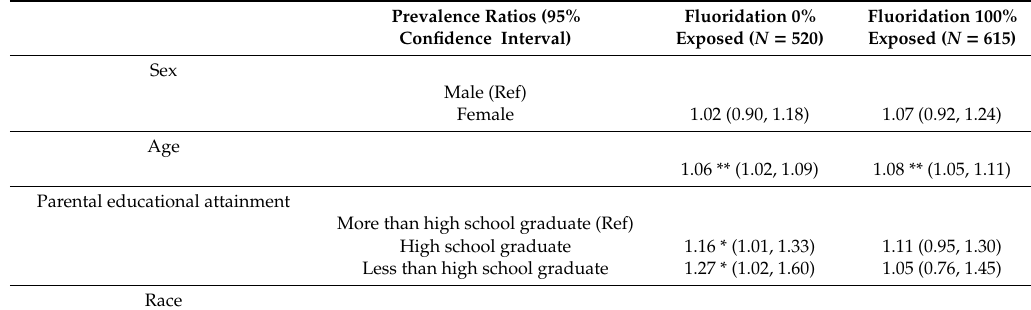
Table 3. Results of Poisson models for fluoridation 0% exposed group and 100% exposed